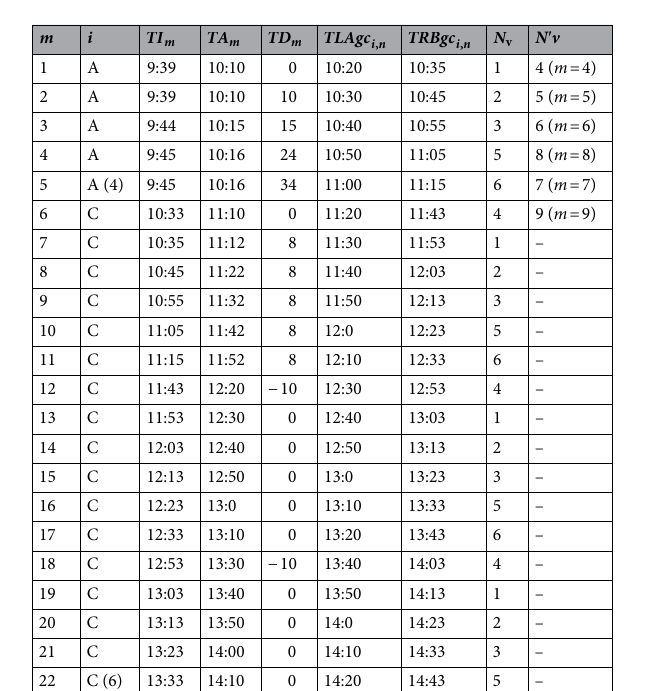
Table 5. The calculation results after the order and the number of trucks are